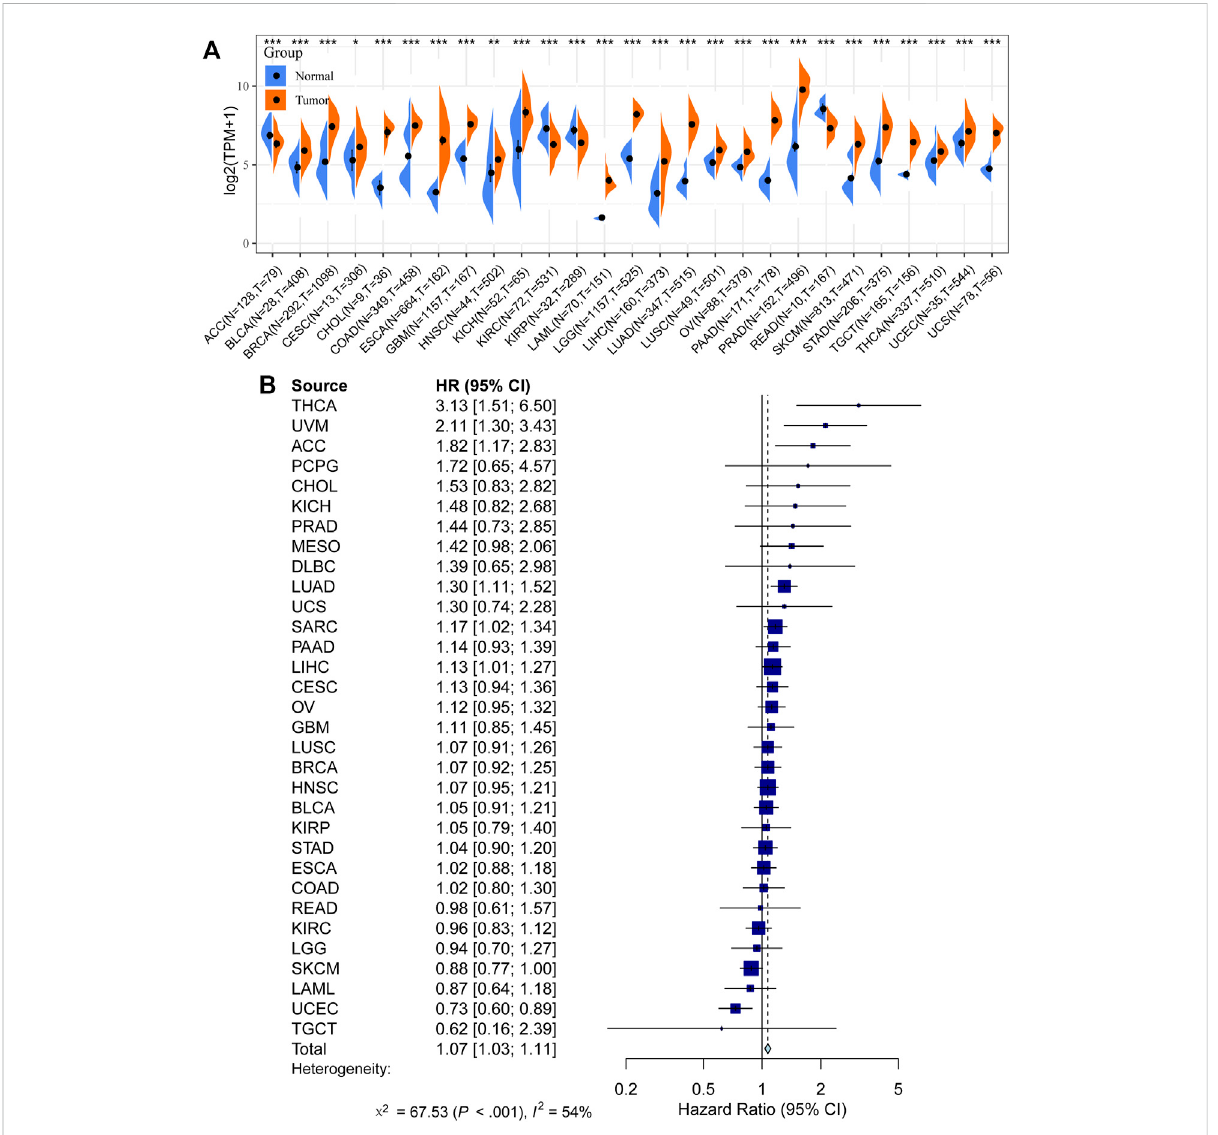
FIGURE 1 PrognosticvalueofGOLM1acrosscancers. (A) DifferentialexpressionofGOLM1innormalandtumortissues; (B) PrognosticvalueofGOLM1for overall survival across